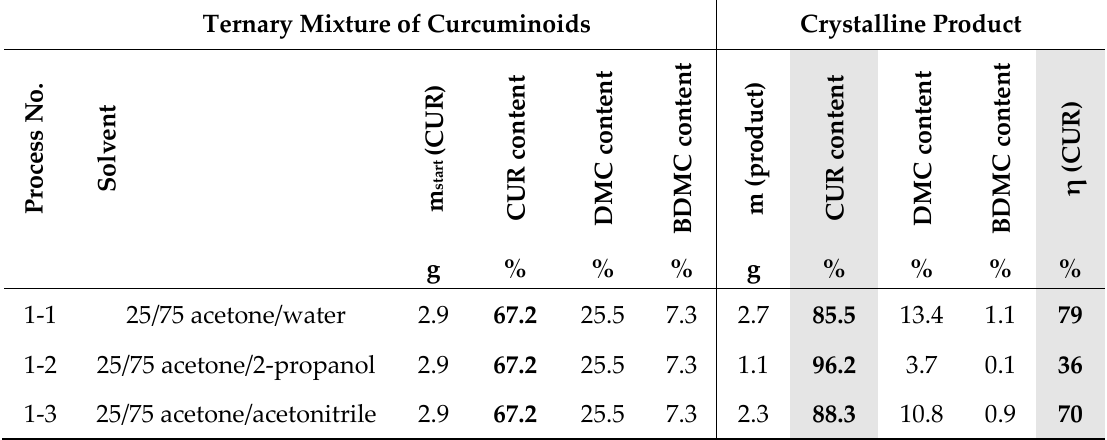
Table 7. Overview of the results to improve total product yield ( η (CUR)) via anti-solvent addition. Ternary Mixture of